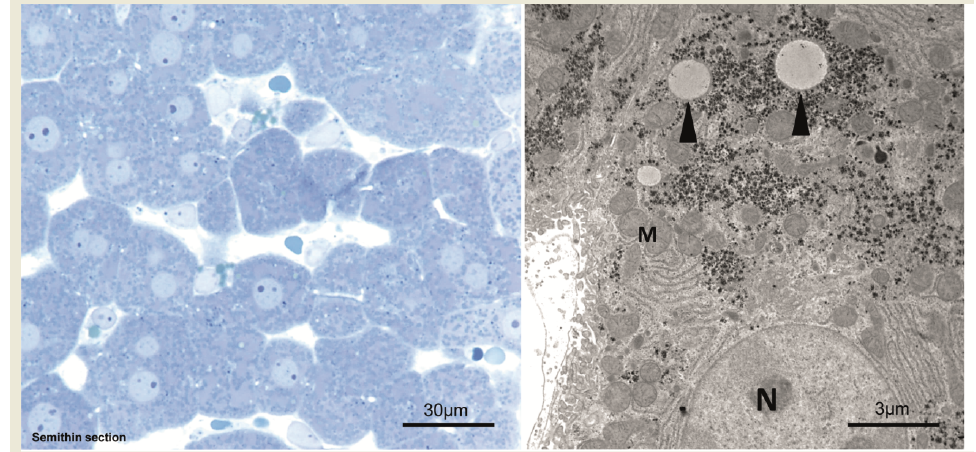
Figure 2. Unaltered hepatocytes before hydrodynamic injection. Left side: Semithin section, Right side:Ultra-structure of unaltered hepatocyte before hydrodynamic injection. N—nucleus; M—mitochondria; arrowheads—lipid vacuoles.